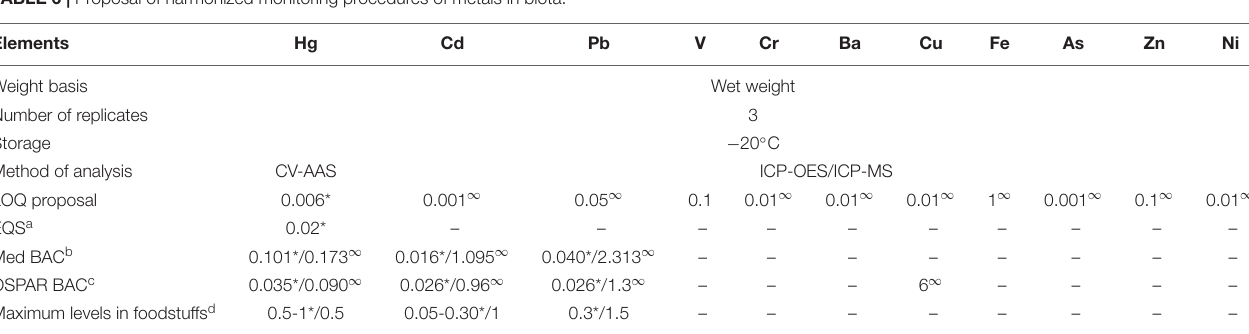
TABLE 6 | Proposal of harmonized monitoring procedures of metals in biota.